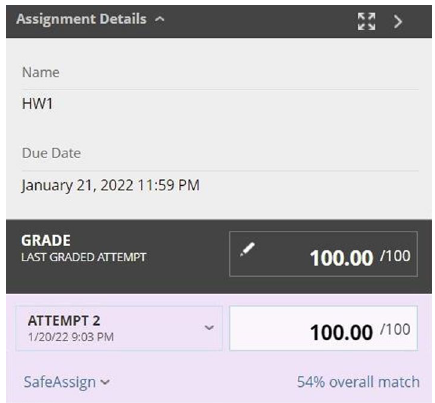
Fig. 2 Snapshot on blackboard